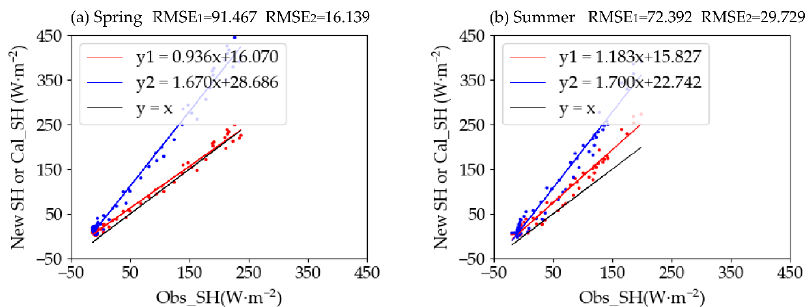
Figure 9. The relationship between the originally calculated SH and observed SH (blue lines, unit: W m − 2 ), and between the new SH and observed SH (red lines, unit: W m − 2 ) in the seasonal mean of the diurnal variation in ( a ) spring and ( b ) summer at NAMORS. RMSE 1 and RMSE 2 denote the root mean squared error of the originally calculated SH and the new SH, respectively.